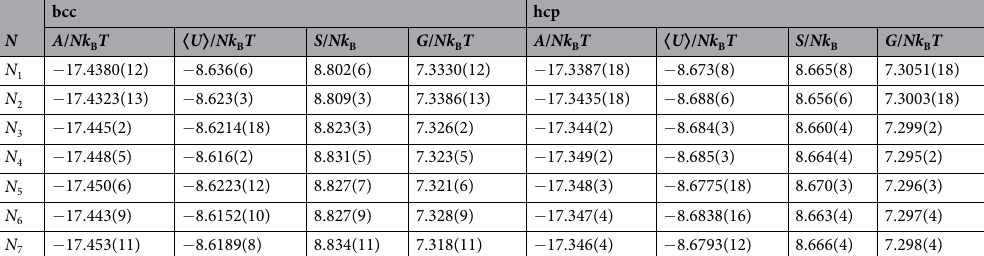
Table 1. Thermodynamic properties computed in this work. N j is the system size as defined in Table 3; A is the Helmholtz free energy; 〈 U 〉 is the internal potential energy averaged in the w = 0 limit; S is the entropy; G is the Gibbs free energy, assuming a pressure of 360 GPa. Numerals in parentheses indicate the estimated error (stochastic + systematic; see text) in the rightmost digit(s) of the reported value. All data are for T = 7000 K and specific volumes of 6.65 Å 3 /atom for the bcc phase, and 6.616 Å 3 /atom for hcp.